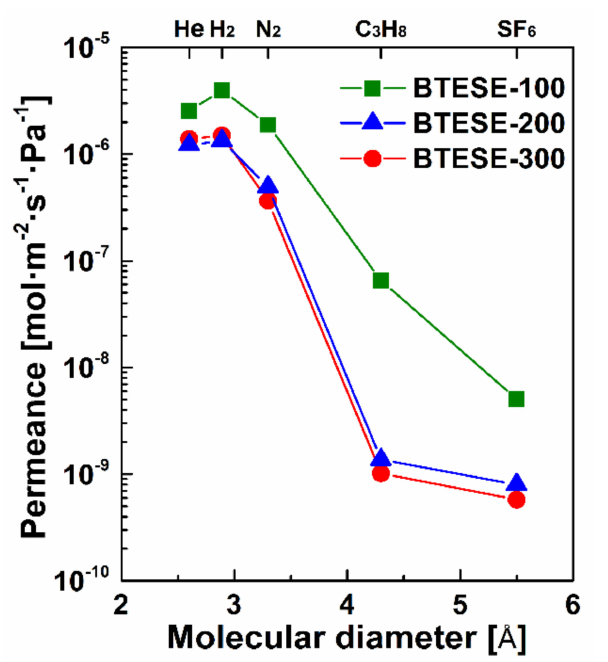
Figure 3. Gas permeation properties of BTESE-100, BTESE-200, and BTESE-300 membranes as a function of molecular size tested at 100 ◦